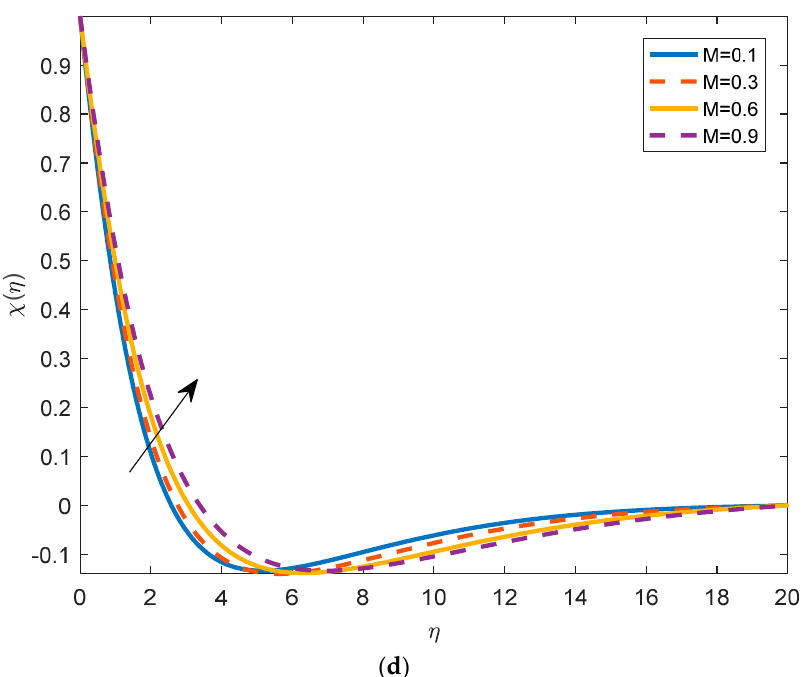
Figure 3. ( a ): Velocity distribution for various M when Rb = 0.1, Nt = 0.1, Nb = 2.0, Pr = 1.5, W e = 0.2, λ = 0.2, Sc = 0.5, Sc n = 0.5, Pe = 1.0, K p = 0.1 at α = π /6. ( b ): Temperature distribution for various M when Rb = 0.1, Nt = 0.1, Nb = 2.0, Pr = 1.5, W e = 0.2, λ = 0.2, Sc = 0.5, Sc n = 0.5, Pe = 1.0, K p = 0.1 at α = π /6. ( c ): Concentration distribution for various M when Rb = 0.1, Nt = 0.1, Nb = 2.0, Pr = 1.5, W e = 0.2, λ = 0.2, Sc = 0.5, Sc n = 0.5, Pe = 1.0, K p = 0.1 at α = π /6. ( d ): density of motile micro-organisms for various M when R b = 0.1, N t = 0.1, N b = 2.0, Pr =1.5, W e = 0.2, λ = 0.2, Sc = 0.5, Sc n = 0.5, Pe = 1.0, K p = 0.1 at α = π /6.